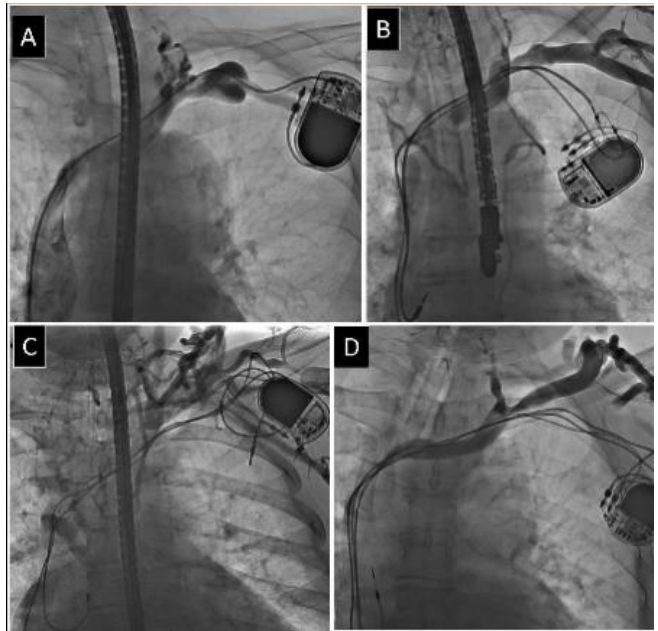
Figure 1. Different degree of obstruction of axillary vein. ( A ) Mild narrowing of axillary vein. ( B ) Moderate narrowing of axillary vein. ( C ) Severe narrowing of axillary vein. ( D ) Complete occlusion of axillary vein.